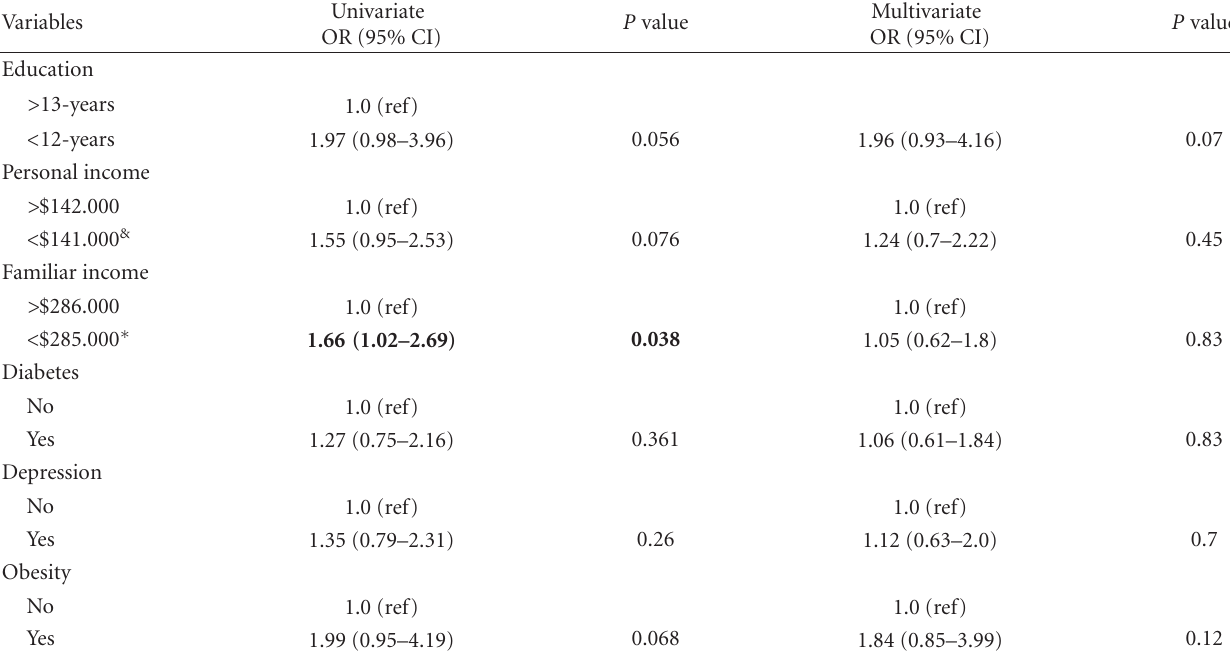
Table 5: Nonadjusted and adjusted odds ratios (ORs) and 95% confidence interval (95% CI) related to tooth loss (the presence of less than 21 teeth in mouth) for the 65–74-year-old